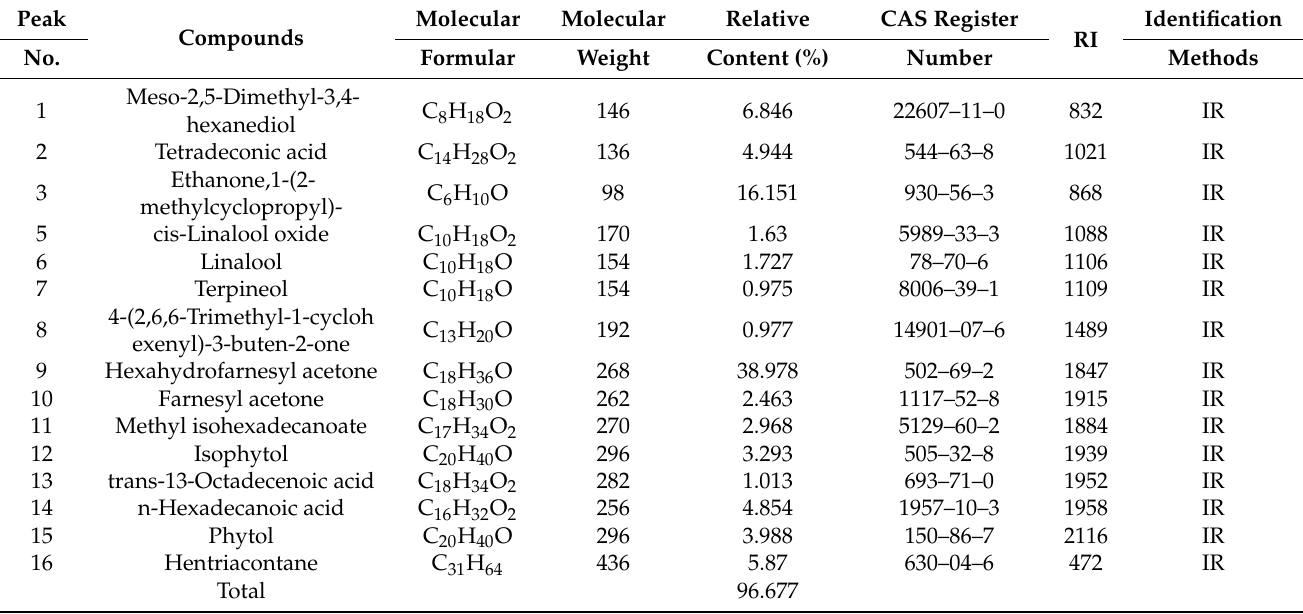
Table 1. Chemical composition of essential oil from S. chamaejasme